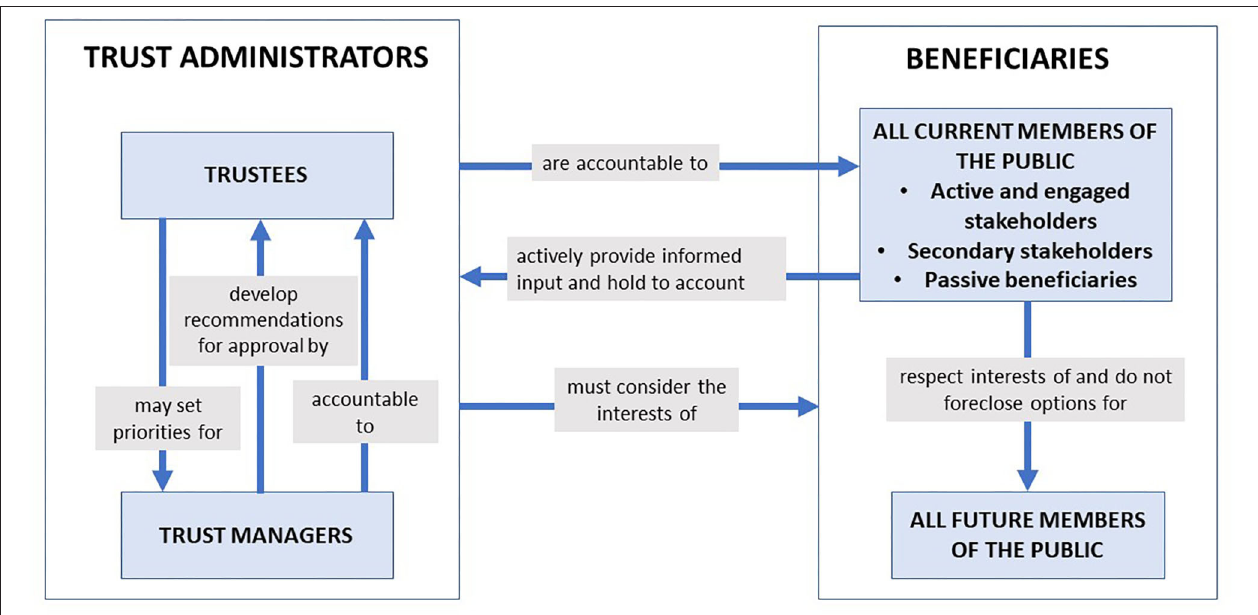
FIGURE 1 | Relationships between categories of actors in public wildlife governance in the United States. Public wildlife trust administrators comprise trustees (elected and appointed officials) and trust managers (various types of professionals employed by public wildlife agencies). Beneficiaries comprise all current and future members of the public. Current beneficiaries hold trust administrators accountable in many direct and indirect ways. Beneficiaries have an obligation to be active, adequately informed participants in decision making. Beneficiaries and trust administrators must consider the interests of future generations and avoid foreclosing options for future wildlife resource